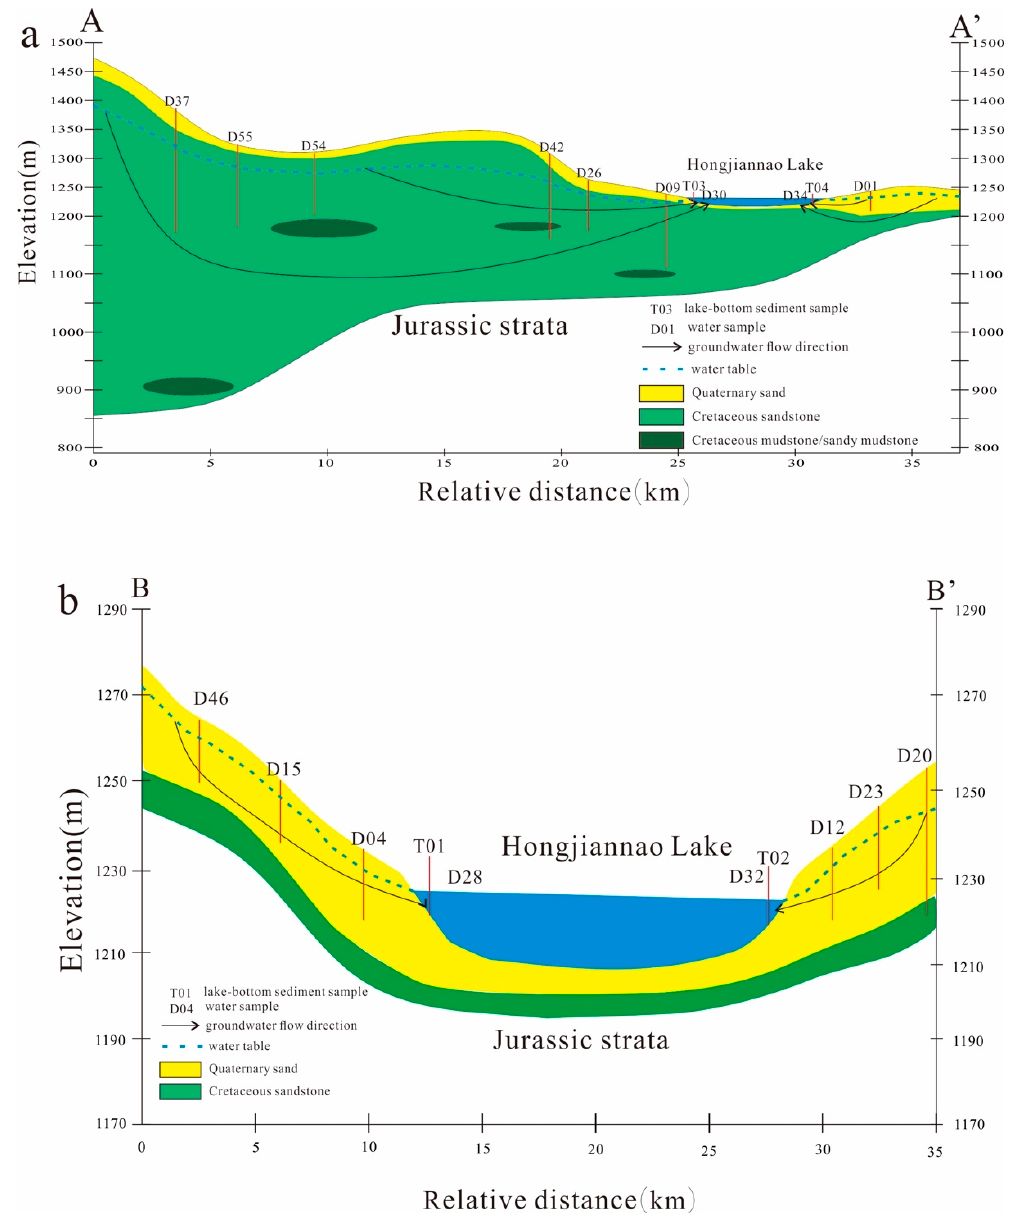
Figure 3. Hydrogeologic profile of the A–A’ ( a ) and B–B’ ( b ) and sampling locations (refer to Figure 1 for locations in the caption).